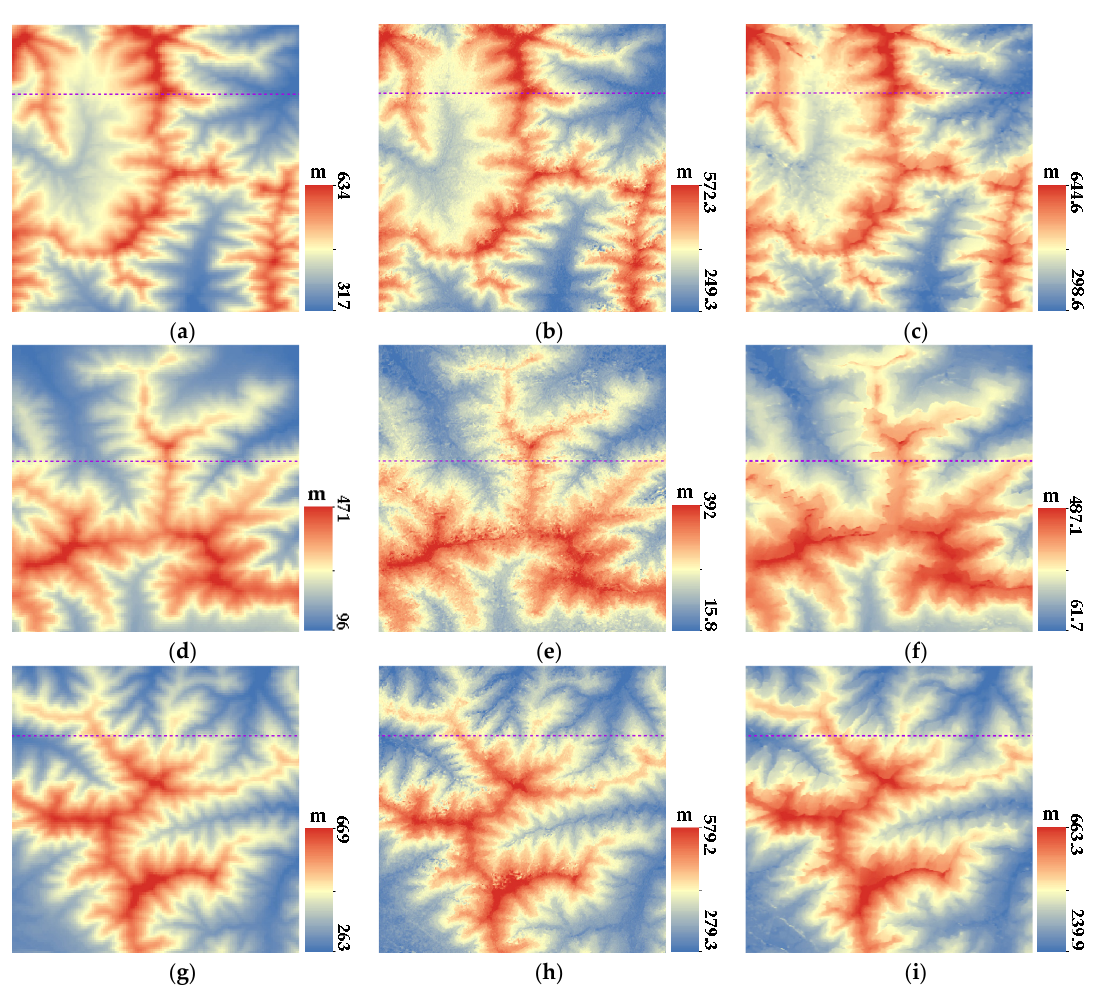
Figure 8. DSM of ridge regions: ( a ) Reference DEM of ridge region 1; ( b ) DSM extracted by ENVI of ridge region 1; ( c ) DSM of this paper of ridge region 1; ( d ) Reference DEM of ridge region 2; ( e ) DSM extracted by ENVI of ridge region 2; ( f ) DSM of this paper of ridge region 2; ( g ) Reference DEM of ridge region 3; ( h ) DSM extracted by ENVI of ridge region 3; and ( i ) DSM of this paper of ridge region